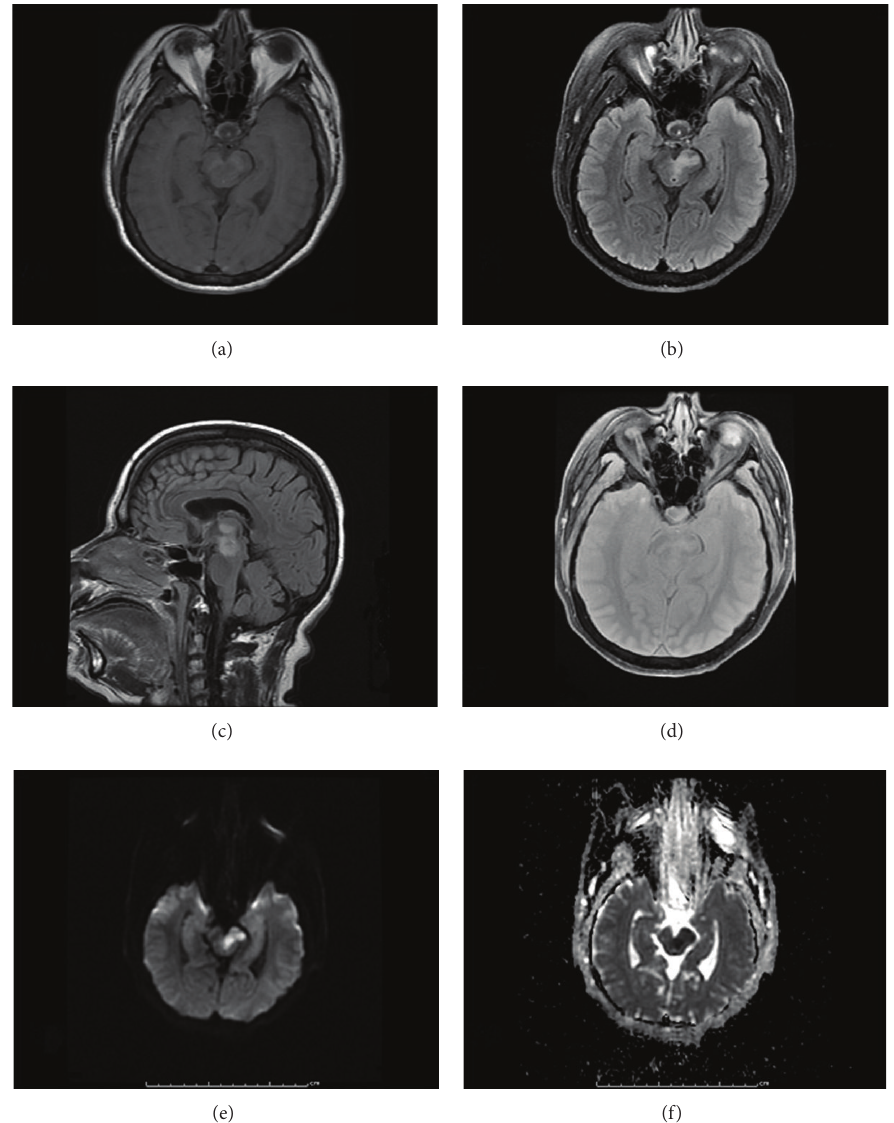
Figure 2: Brain magnetic resonance imaging showing acute infarcts in the thalami, left cerebral peduncle, and mid-brain. (a) Axial T1 weighted image, (b) axial T2 weighted image, (c) sagittal T1 weighted image, (d) axial gradient echo (GRE) image, (e) axial diffusion weighted image, (f) adjusted diffusion coefficient (ADC)